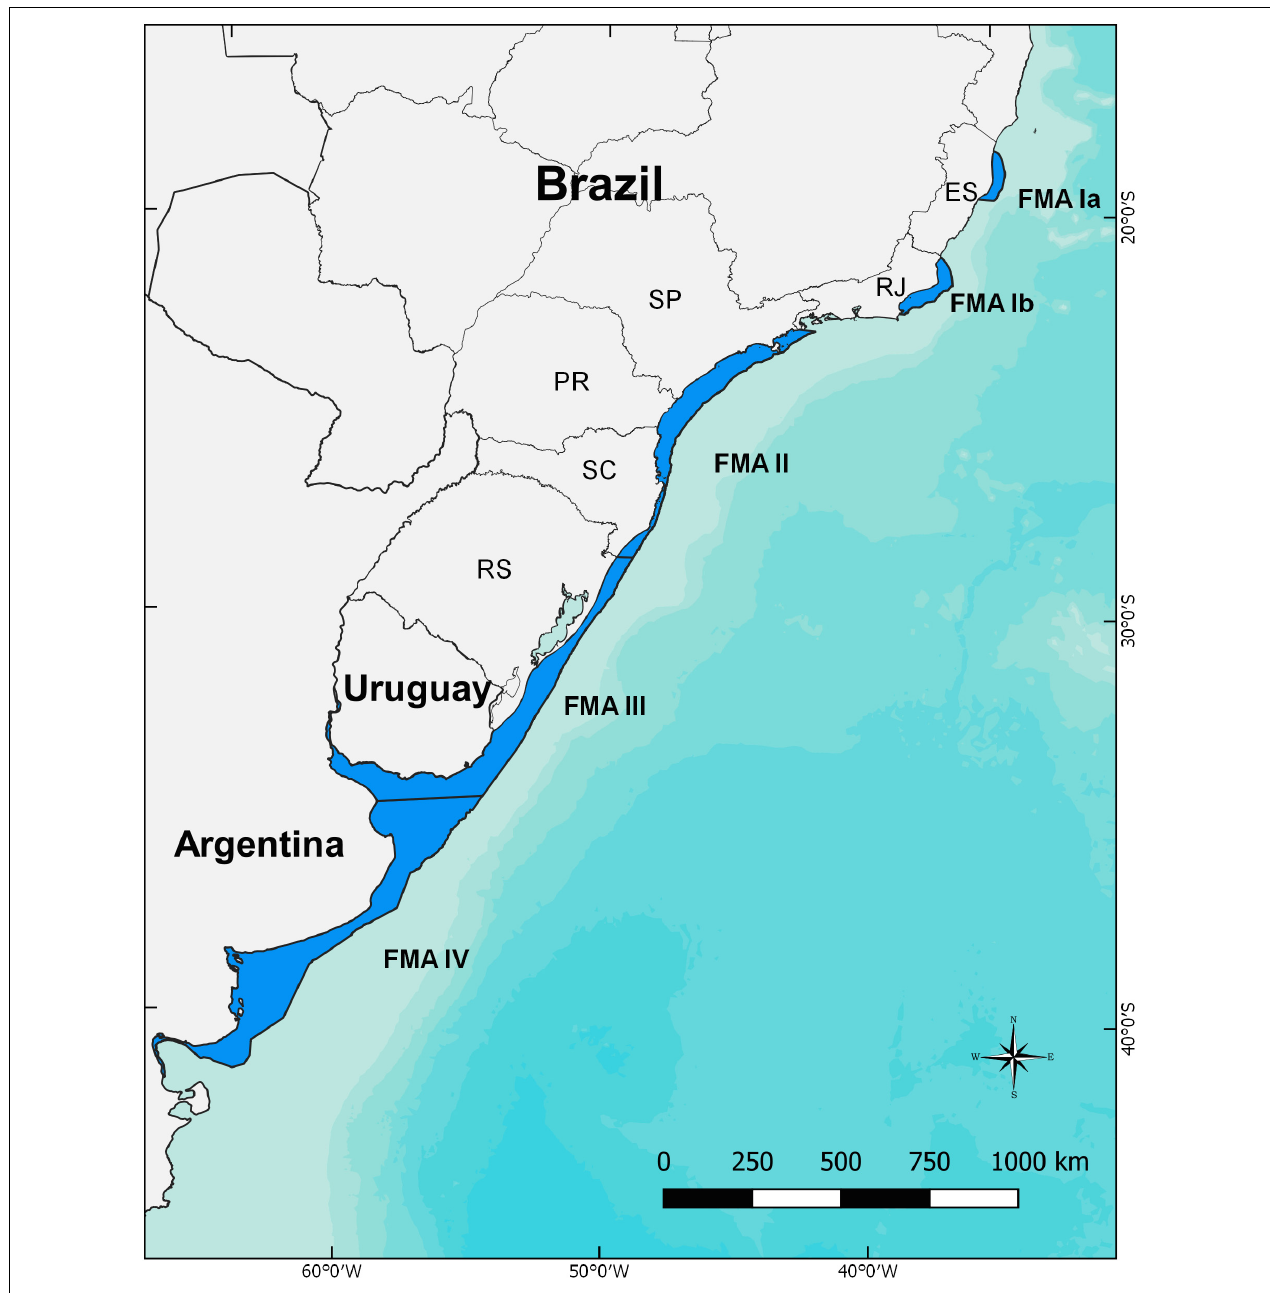
FIGURE 2 | Franciscana distribution in coastal waters of the western South Atlantic and the proposed limits of each Franciscana Management Areas (FMAs – sensu Secchi et al., 2003a). ES, Espírito Santo State; RJ, Rio de Janeiro State; SP, São Paulo State; PR, Paraná State; SC, Santa Catarina State; RS, Rio Grande do Sul